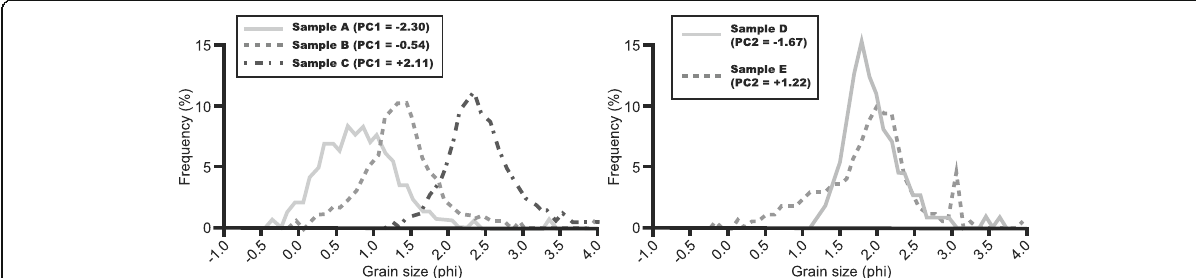
Fig. 10 Typical transformation pattern of the grain-size distribution curves represented by PC1 (left) and PC3 (right). Sampling locations of samples A – E are shown in Fig. 2. The values of PC1 through PC3 for each sample (A – E) are shown in the scatter diagram of Fig. 11 PC3 values (> − 0.3) are found in the northern and south- eastern parts of the sand flat, and this characteristic distri- bution pattern is similar to the map of the mud content (Figs. 7 and 9). The range of variation in PC3 values (from − 2.0 to 2.5) is more limited than for PC1 (from − 4.5 to 4.0) (Fig. 11). Very poor correlation between mud log-